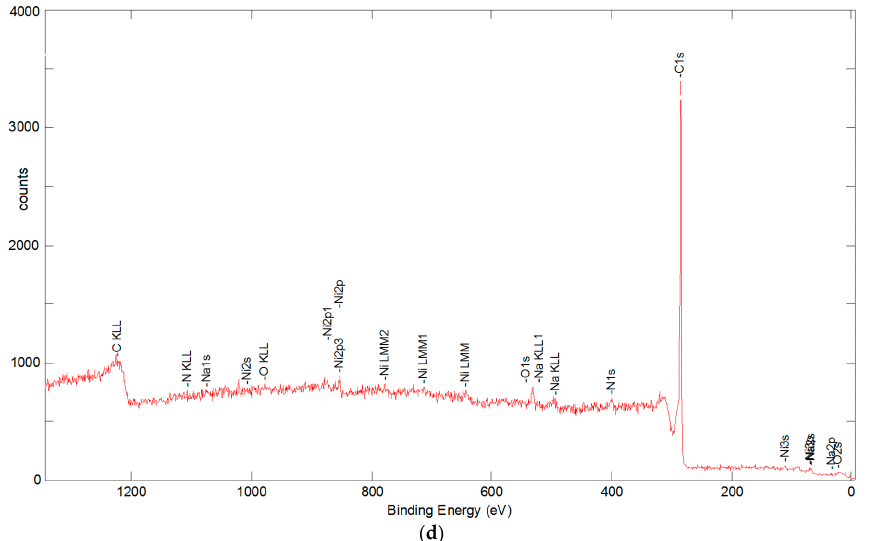
( d ) Figure A1. XPS spectra for sized fabric ( a ); desized at 400 °C ( b ); desized at 600 °C ( c ); or with a 1.4 wt Figure A1. XPS spectra for sized fabric ( a ); desized at 400 ˝ C ( b ); desized at 600 ˝ C ( c ); or with a % CNFs (d). 1.4 wt % CNFs ( d